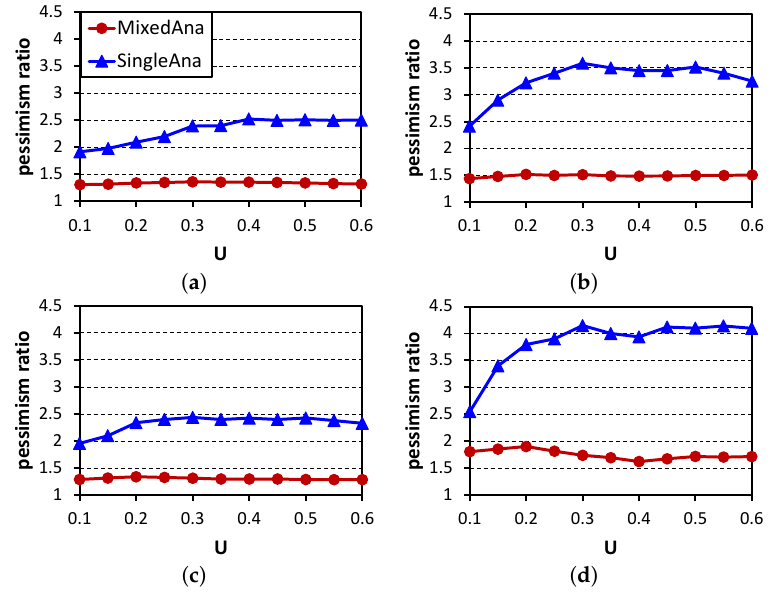
Figure 11. Delay comparison with StealRM being used as the baseline. ( a ) | N | = 20, M = 6, ρ = 0.1; ( b ) | N | = 20, M = 6, ρ = 0.3; ( c ) | N | = 20, M = 9, ρ = 0.1; ( d ) | N | = 60, M = 6, ρ =